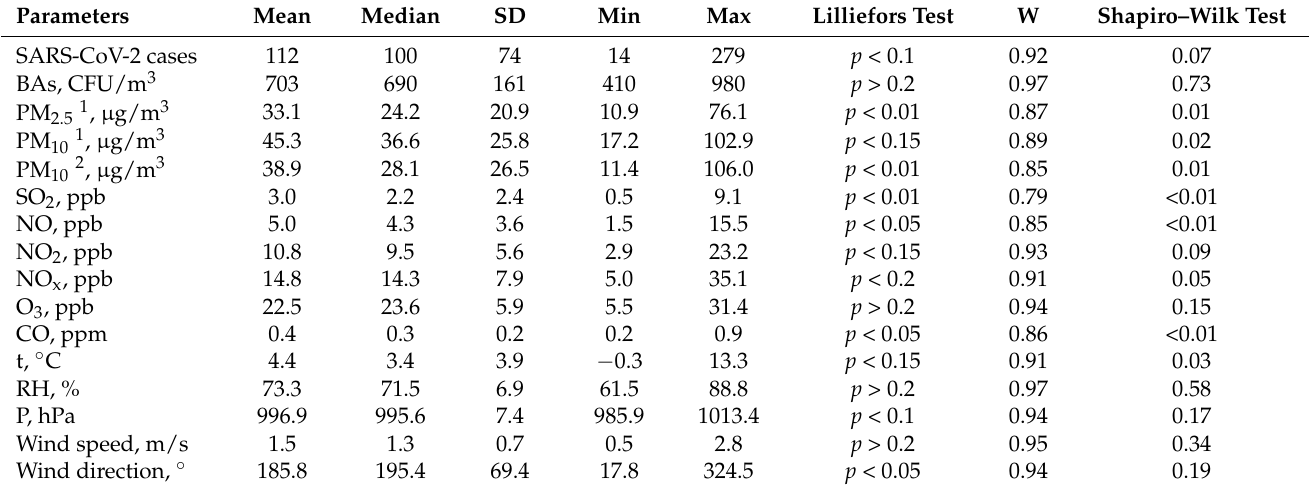
Table 1. Mean, median, minimum, and maximum values of parameters for daily new cases (DNCs) and all variables included in the analysis for March